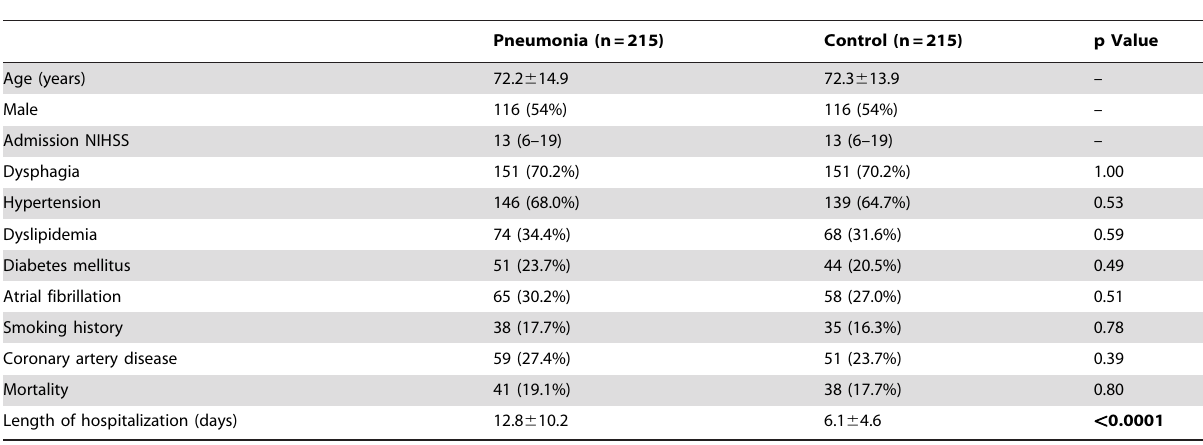
Table 1. Clinical characteristics and short-term outcomes of HAP patients and matched